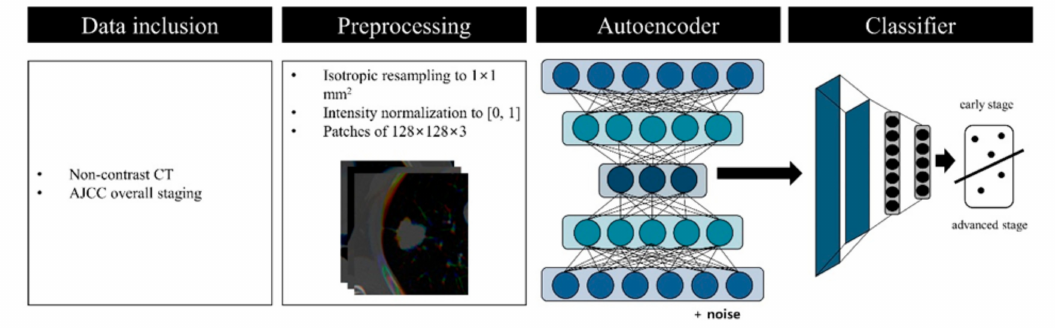
Figure 1. Overall